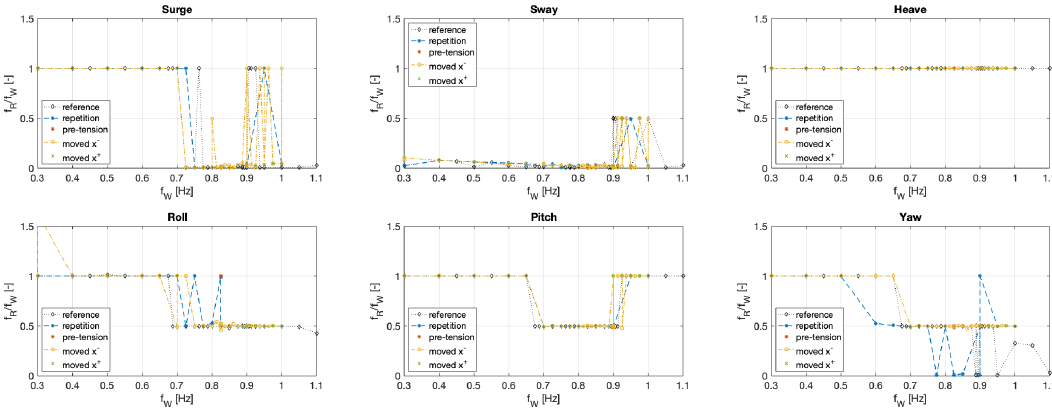
Figure 6. Frequency response f R normalised by and presented in relation to the requested wave frequency f W for the amplitude results in Figure